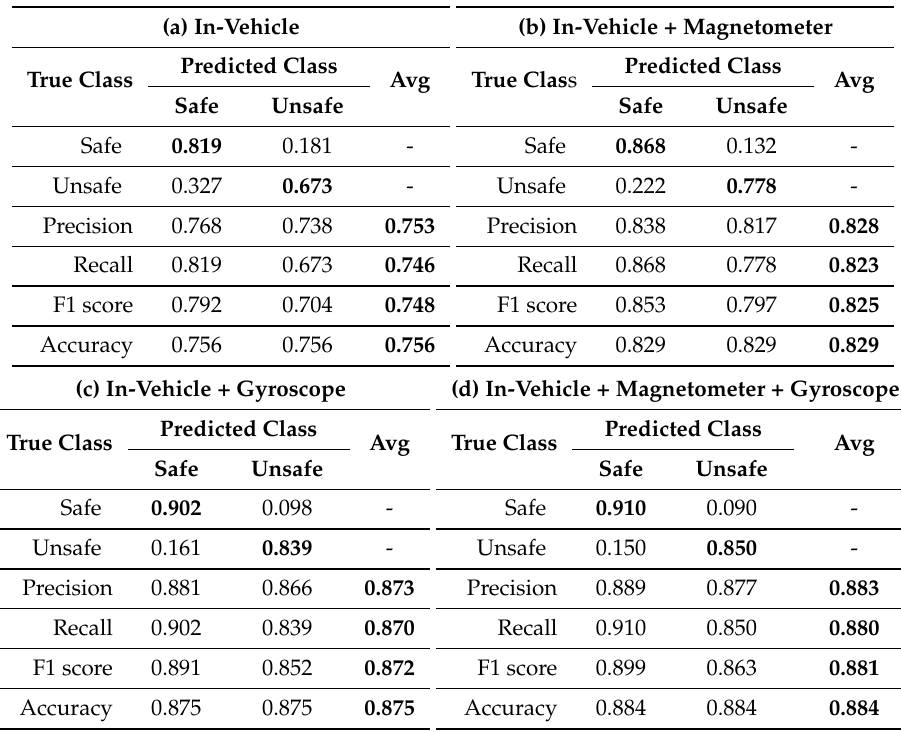
Table 1. Confusion matrices and classification performance of the SVM model while trying to distinguish safe and unsafe driver behaviors with different adopted features. Table ( a ) reports the results obtained with only in-vehicle sensors’ features; Table ( b ) with in-vehicle sensors and magnetometer features; Table ( c ) with in-vehicle sensors and gyroscopic features; and Table ( d ) with all features